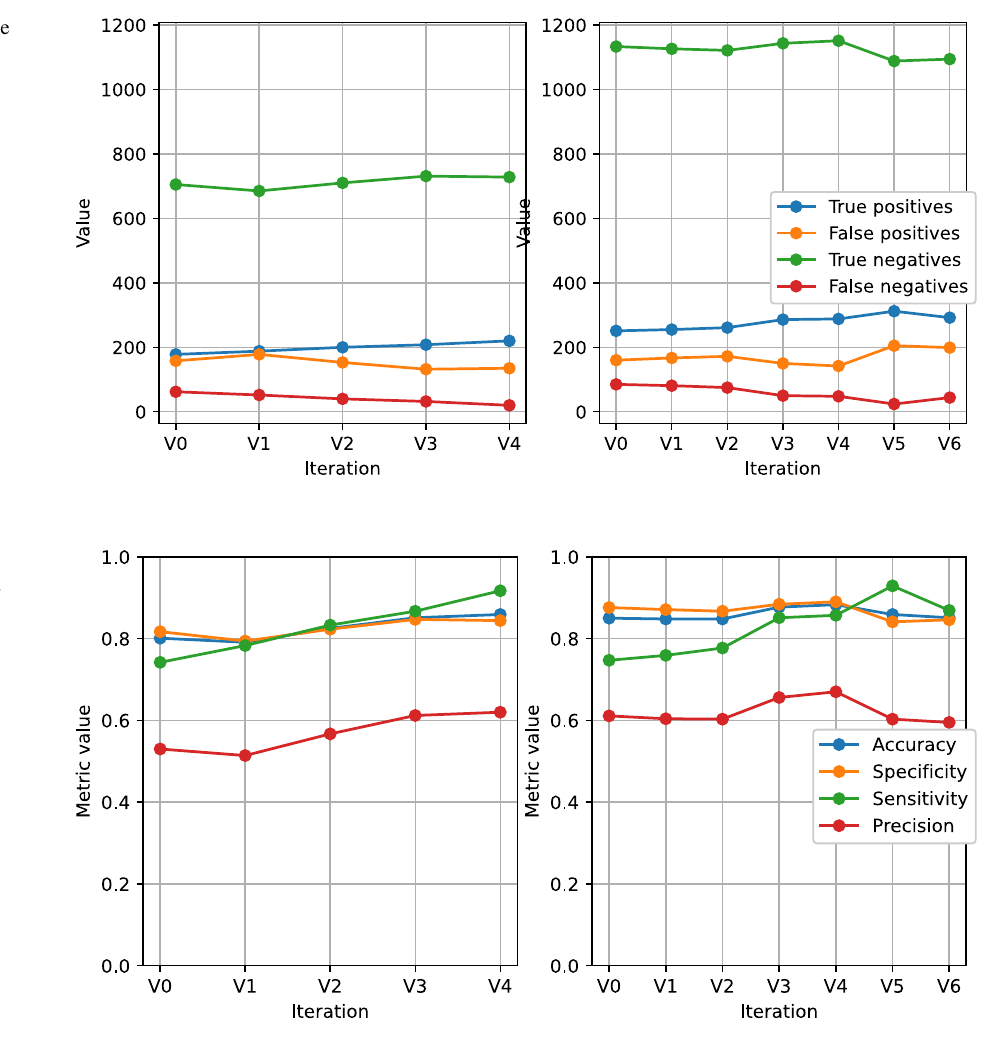
Fig. 6 Confusion matrix on the test set. Diabetic retinopathy (left) and occupancy (right)